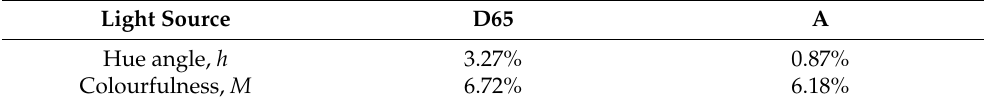
Table 7. CV of hue angle and colourfulness under different light sources.